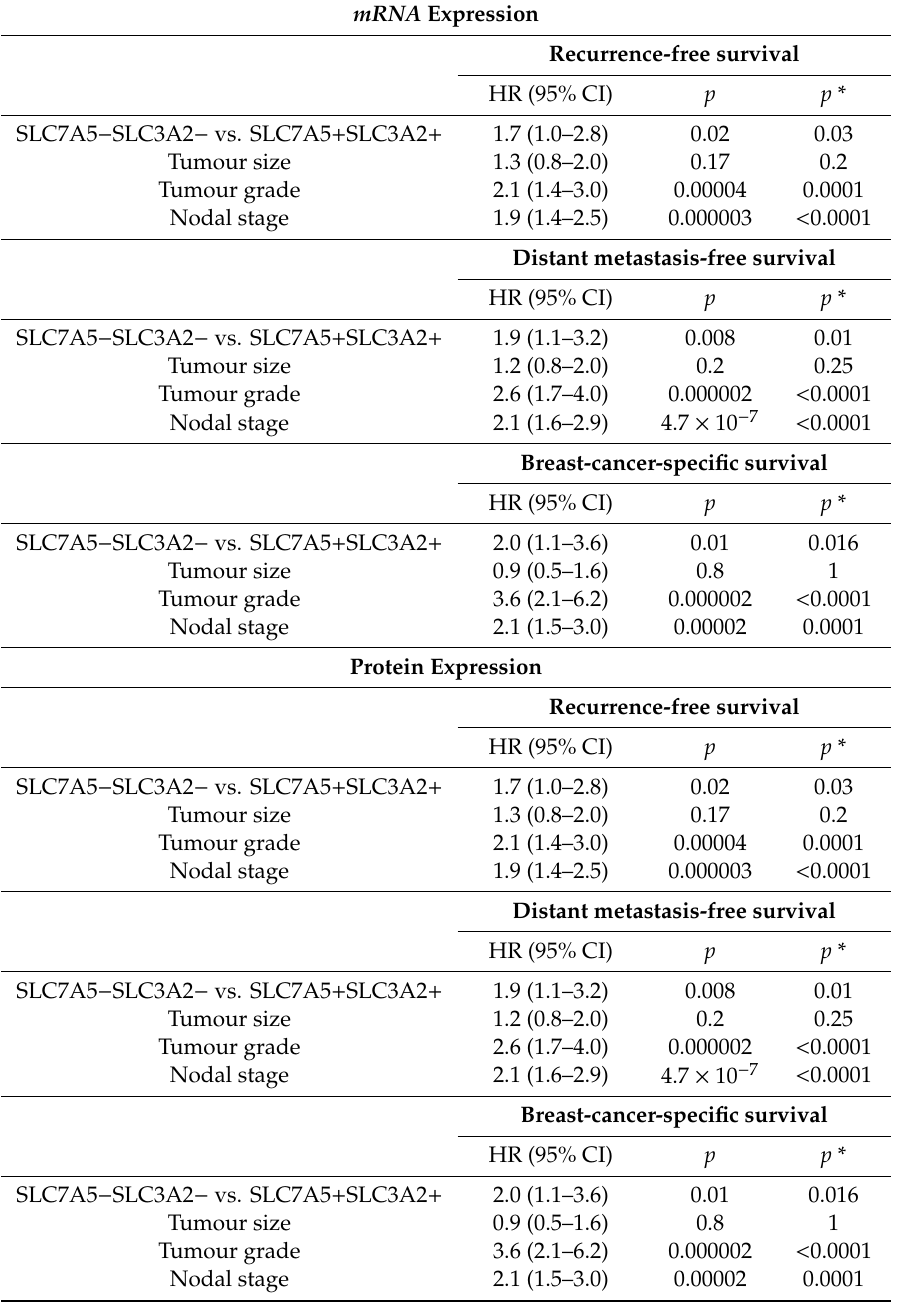
Table 4. Multivariate cox analysis of associations between SLC7A5 / SLC3A2 co-expression and clinicopathological parameters in the endocrine-treated